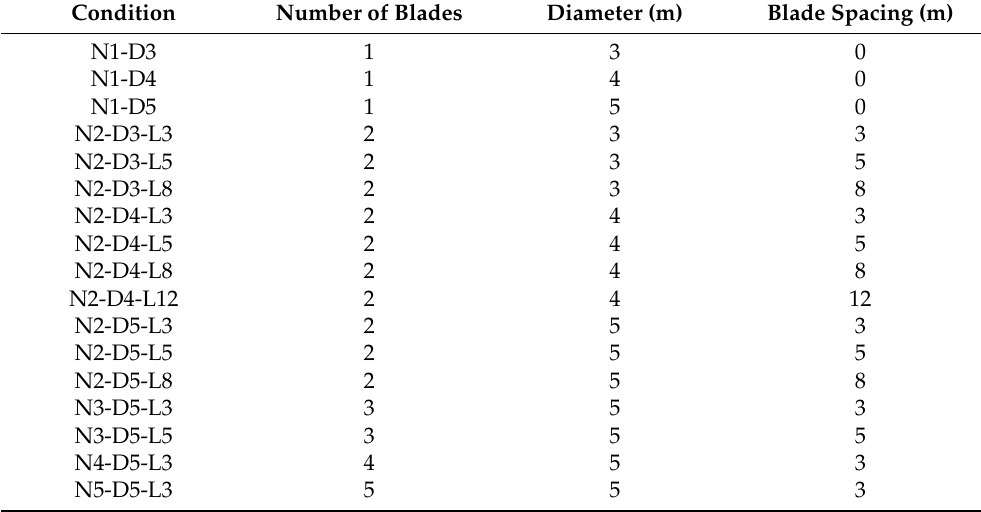
Table 5. Multi-blade finite element